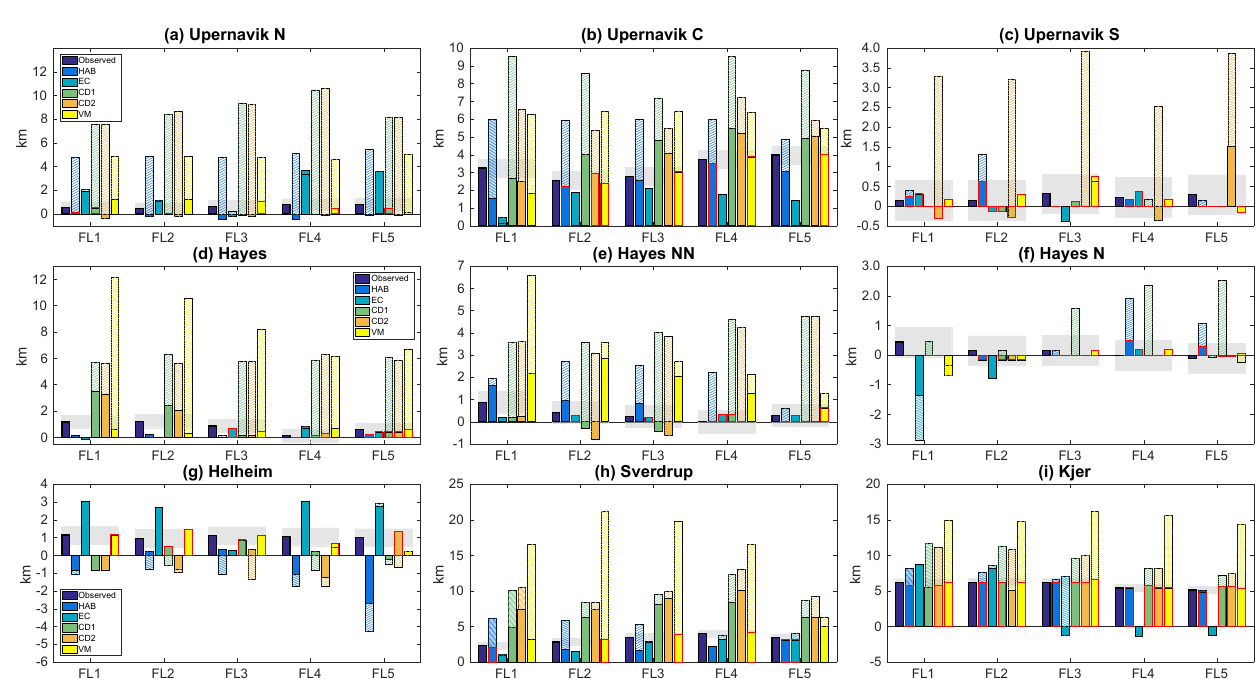
Figure 6. Same as Fig. 2 but for Kjer glacier.